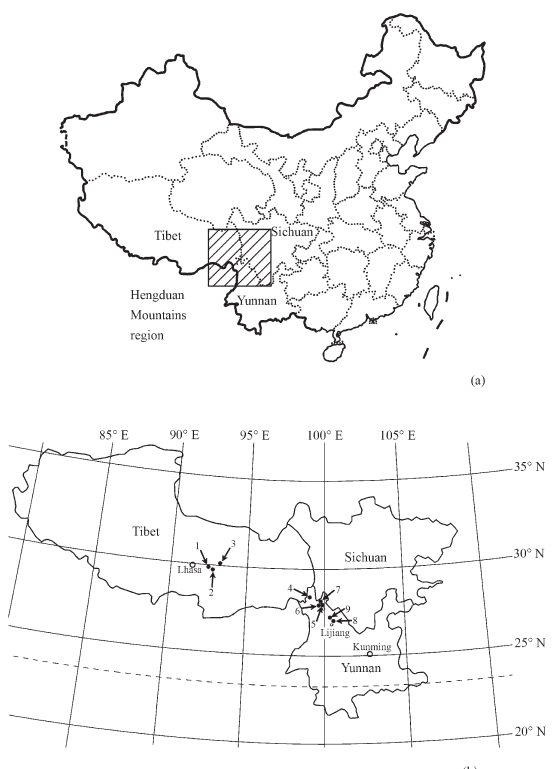
Figure 1 - Samples of nine Rhodiola crenulata populations from the Hengduan Mountains region, China. (a) the Hengduan Mountains region; (b) sampling locations. Population codes and the number of plants sam- pled are given in Table